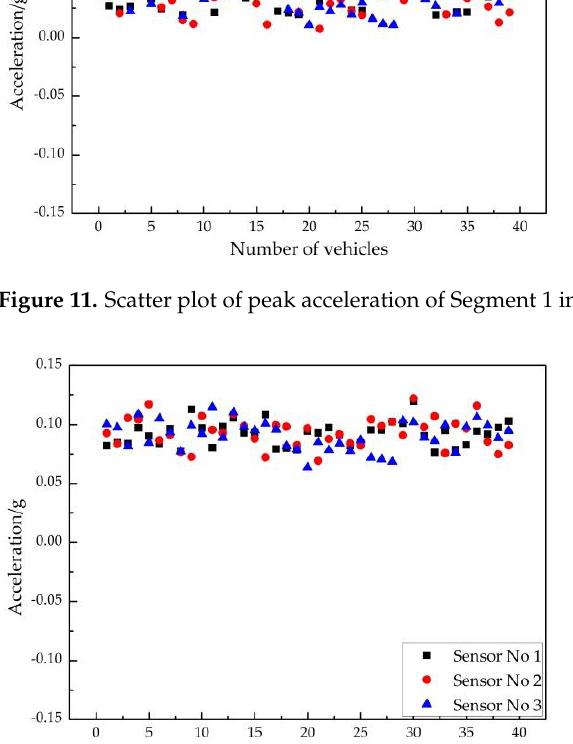
Figure 12. Scatter plot of peak acceleration of Segment 2 in the current monitoring stage.